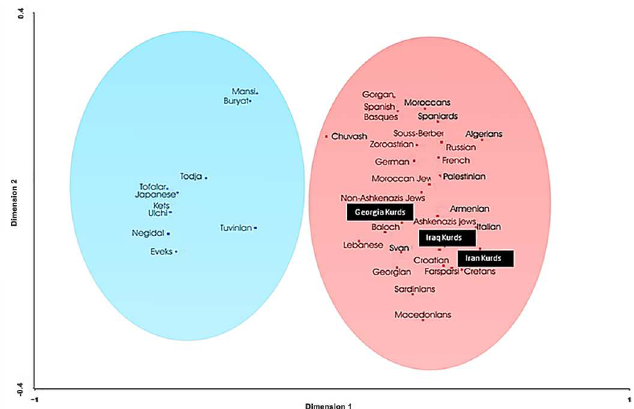
Fig 3. Correspondence analysis. Correspondenceanalysisshowinga globalview of the relationship betweenKurds and Mediterranean, Siberiansand other World populationsaccordingto HLA-DRB1 (low resolutions) allelefrequenciesin three dimensions (bidimensional